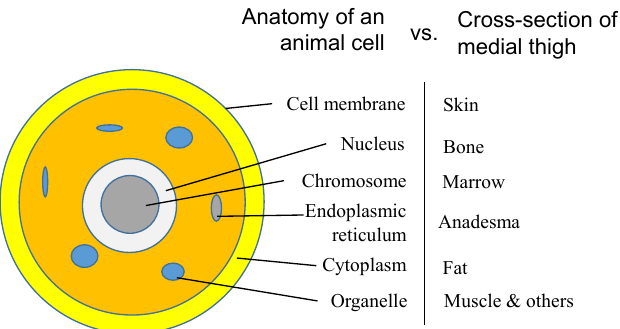
Figure 6. Analogy between the anatomy of an animal cell and that of the cross ‐ section of the medial thigh.